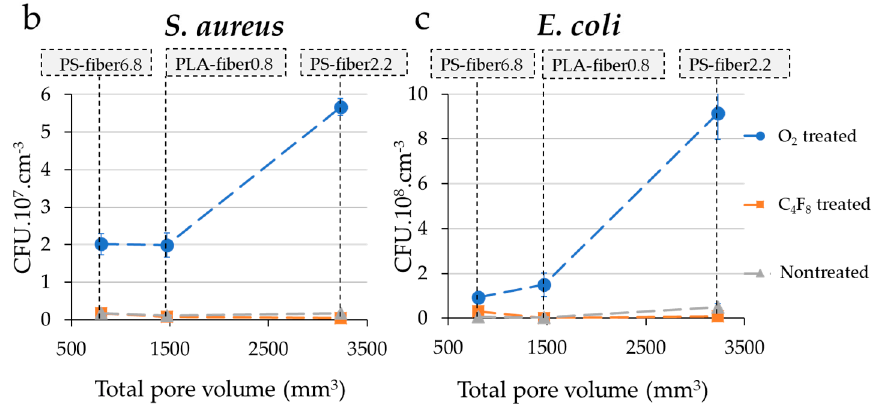
Figure 4. Morphology and pore characteristics of substrates. ( a ) Solidity, SEM image (inserted scale bar is 2 µ m), and schematic illustration of the relative size of fibers and pores for different substrates; ( b ) S. aureus adhesion with a varied pore volume of substrates; ( c ) E. coli adhesion with a varied pore volume of substrates.